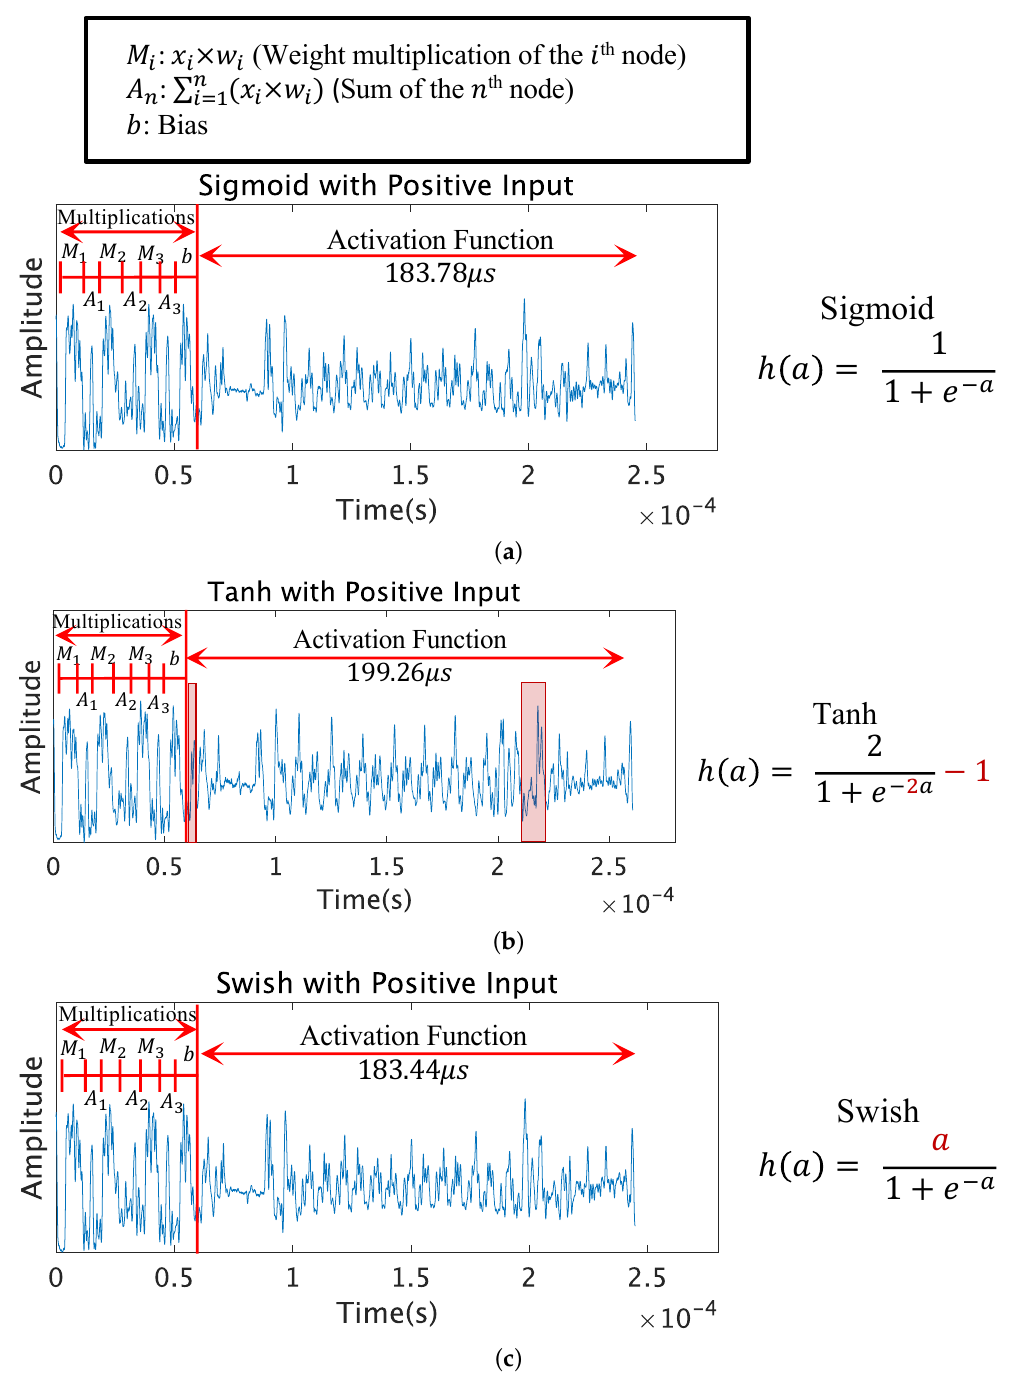
Figure 4. Comparison of the Patterns of Sigmoid, Tanh, and Swish Functions for Positive Input. ( a ) Sigmoid Function. ( b ) Tanh Function. ( c ) Swish